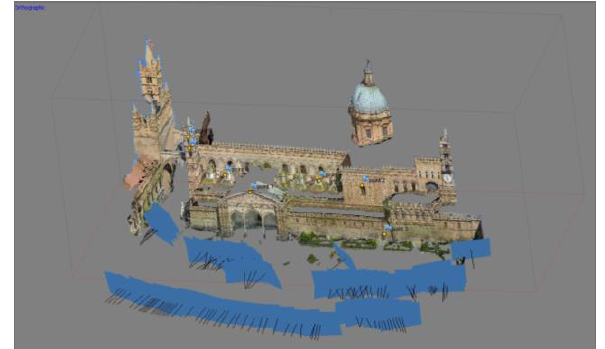
Figure 8. Data set for Street Level model: chunk